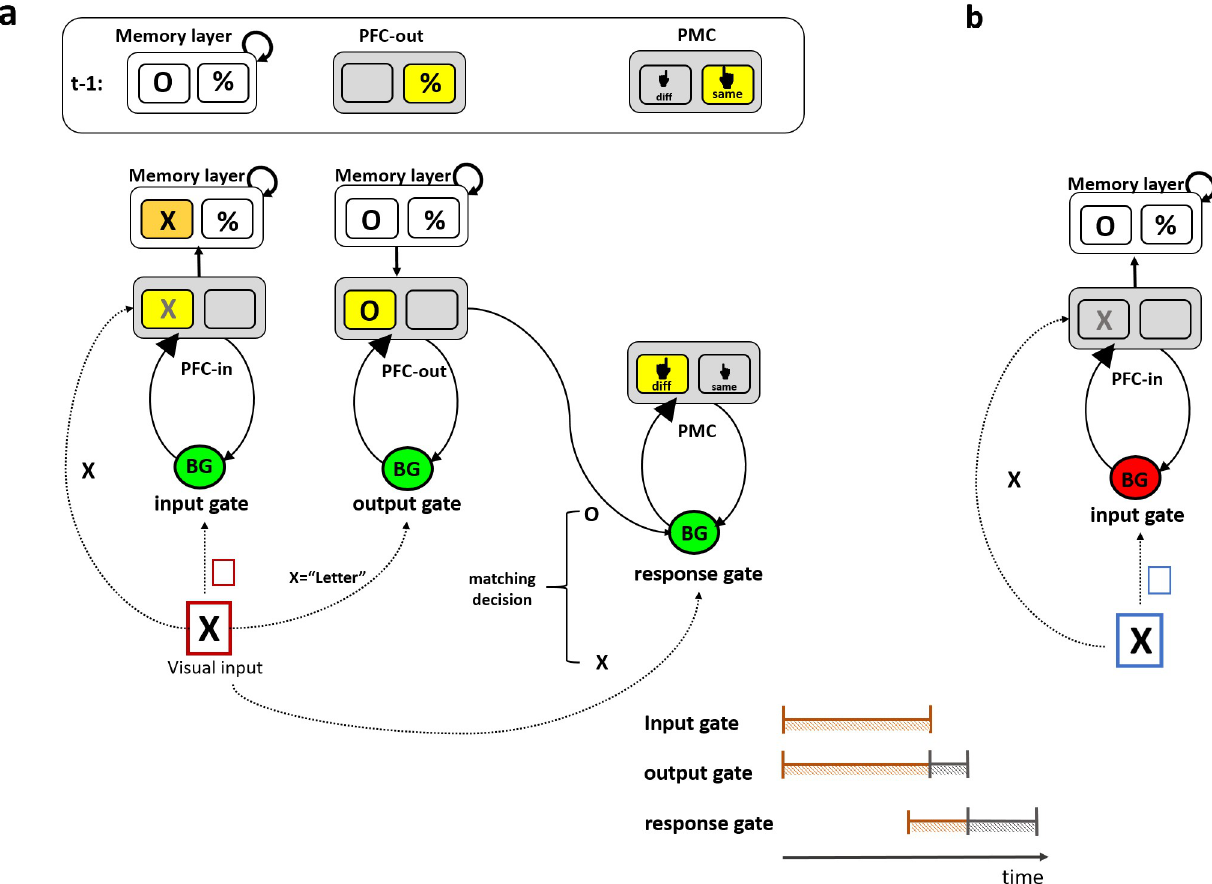
Fig 1. Schematic of the PBWM architecture for canonical gating operations. (a) The gating system is composed of three core circuits that are hierarchically arranged from left to right. For illustration the operations needed to solve the task used in this paper are shown. At the beginning of a trial, the memory layer actively maintains the information from the previous trial (e.g., “O” and “%”). Sensory information (e.g., the “X” in the visual input) is transiently represented in a prefrontal cortex layer (labeled “PFC-in”). The input gate controls whether the new visual information (e.g., “X”) is updated to be maintained in a PFC memory layer, and if so, to which address or anatomical “stripe” within that layer (selective gating). The colored frame in the visual input represents a task cue signifying the updating policy that should be taken by the input gate. In this example, the red frame indicates that memory should be updated, so the input gate selectively updates the right PFC stripe (corresponding with the letter category, replacing the “O” in memory with “X”). The output gate controls which memory representations is prioritized in PFC-out (e.g., a deep layer of the PFC) to influence subsequent processing (e.g., here the relevant representation in memory is “O” and not “%”, given that the input to be compared is in the letter category). The response gate controls which motor response to select (e.g., here “same” (S) or “different” (D)) in posterior prefrontal layer (labeled here PMC), by comparing the output-gated memory representation (“O”) with the current visual input (“X”). Gate switching at the output and response gates are reflected by the change in the active stripe between the previous trial (t-1) and in the current trial. (b) An example of a maintenance trial. The blue task cue indicates that the appropriate updating policy is maintenance, and thus sensory information (e.g., “X”) is prevented from being updated in PFC memory (the gating signal from the BG is therefore a No-Go, indicated by the red BG). Gate switching in the input gate corresponds with moving between updating state (as shown in a) and maintenance state (as shown in b). Yellow squares indicate active stripe selected by the corresponding gate. The orange square represents the newly updated stripe in memory. The predicted temporal order of the gating loops is depicted at the bottom right of the figure with input and output gating starting roughly at the same time continuing in parallel (indicated in orange) with output gating terminating later (serial termination indicated in grey). The response gate is expected to initiate with some delay due to conflict at upper levels, and to terminate even later than the output